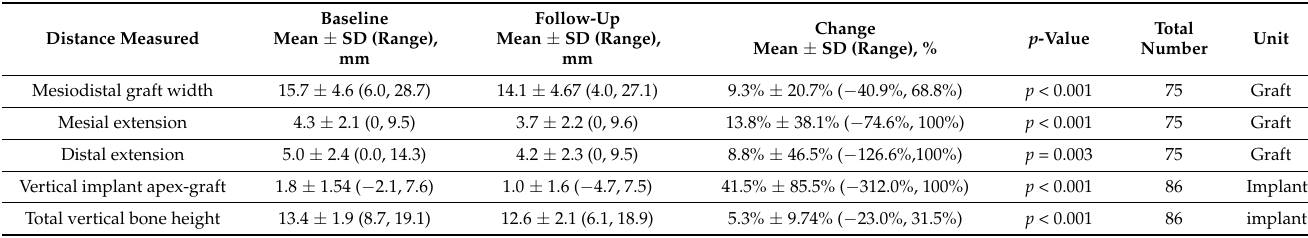
Table 4 describes the main results of the dimensional changes of the graft. All the data are presented in mm as mean values and standard deviations, except for changes that are expressed as percentages, after normalization of the actual change in mm by the baseline distance. Overall, the grafting material resorbed significantly in both mesiodistal and corono-apical dimension. Table 4. Dimensional measurements of the graft, changes, and